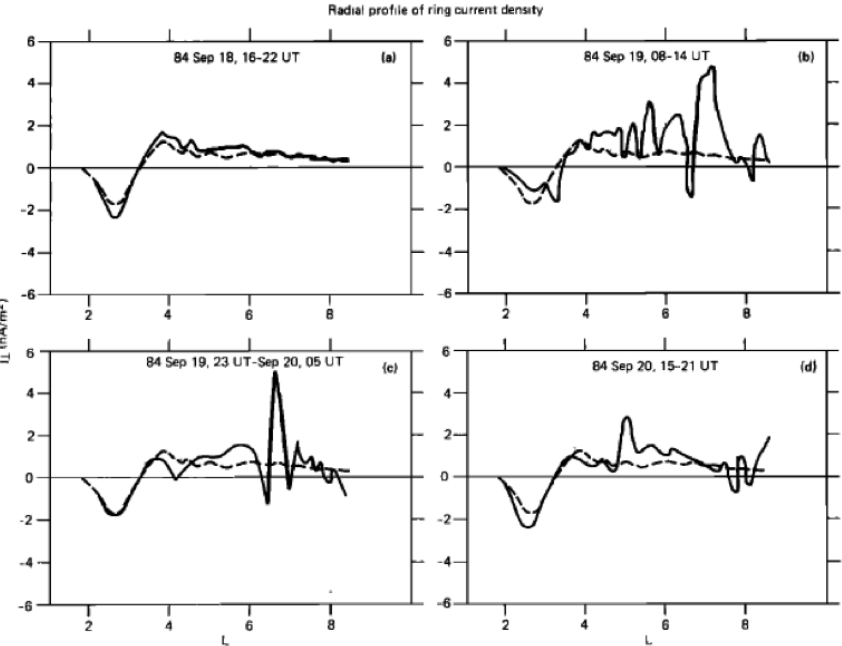
Figure 2. The radial profiles of the current densities for the four passes during the 18–20 September 1984 storm (Fig. 8 from Lui et al., 1987).